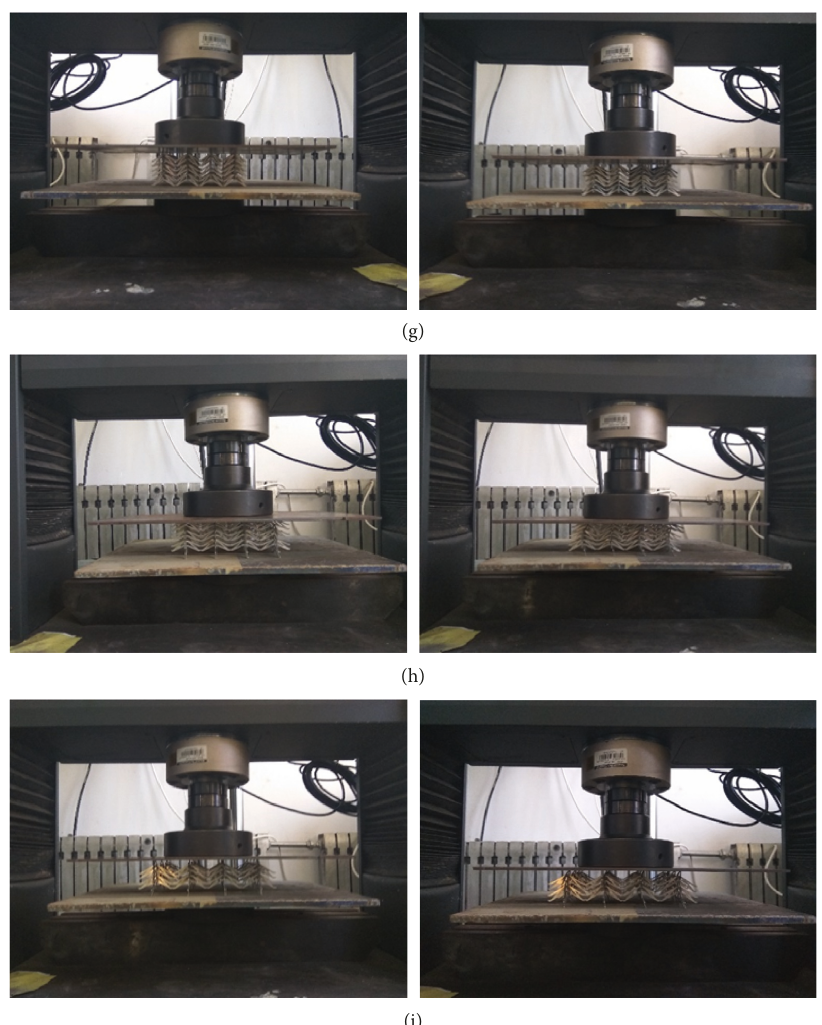
Figure 5: Comparison of samples before and after tests. (a) Sample 1 before and after test. (b) Sample 2 before and after test. (c) Sample 3 before and after test. (d) Sample 4 before and after test. (e) Sample 5 before and after test. (f) Sample 6 before and after test. (g) Sample 7 before and after test. (h) Sample 8 before and after test. (i) Sample 9 before and after